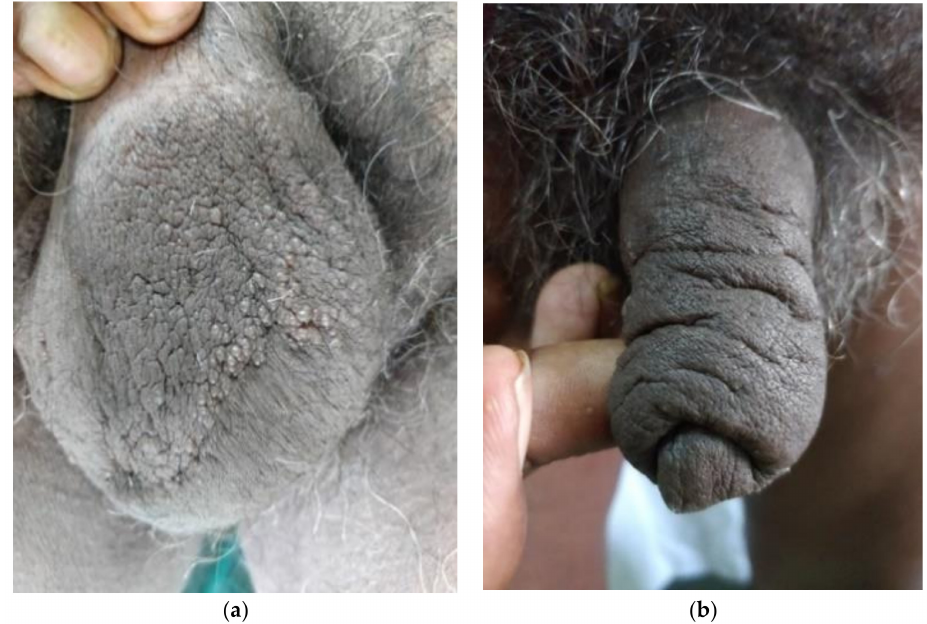
Figure 2. ( a ) Lymphangiectasias on the scrotum with thickened surrounding skin. ( b ) Penile elephantiasis.